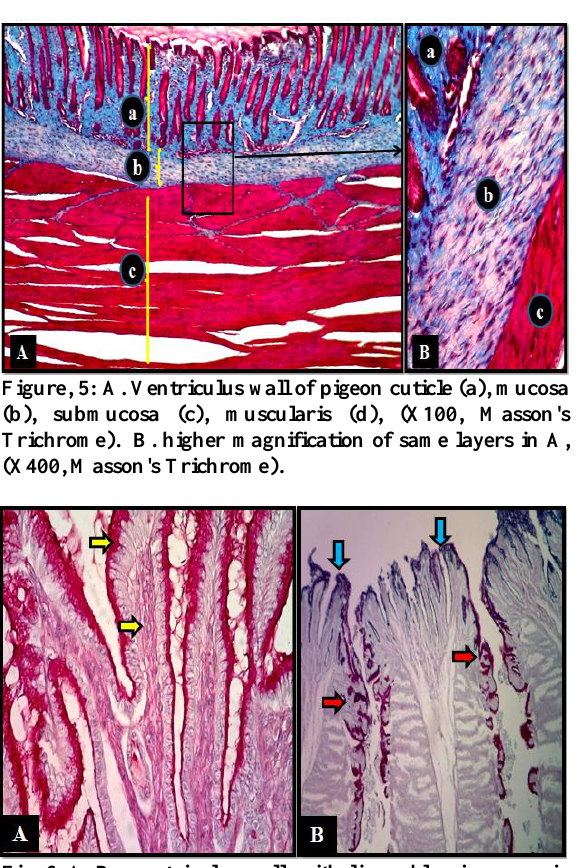
Fig. 6. A. Proventriculus wall epithelia and lamina propria (purple color) (yellow arrows), (PAS, X 400). B. Proventriculus wall neutral (red arrows) and acid mucin (blue arrows), [AB-PAS (pH 2.5),